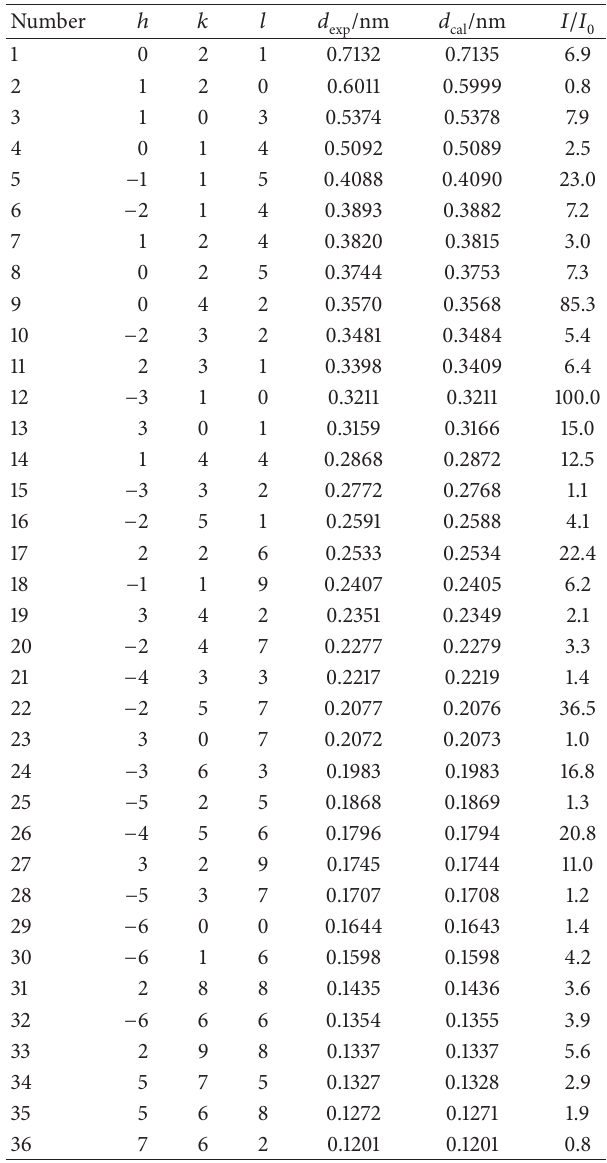
Table1:Theexperimentaldataandthecalculatedresultsforpowder X-ray diffraction pattern of title complex (monoclinic system: 𝑎 =